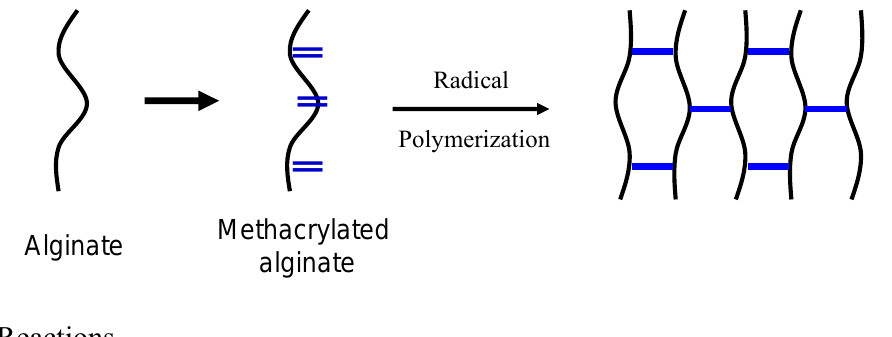
Figure 4. Schematic illustration of the preparation of methacrylated alginate and photocrosslinking of methacrylated